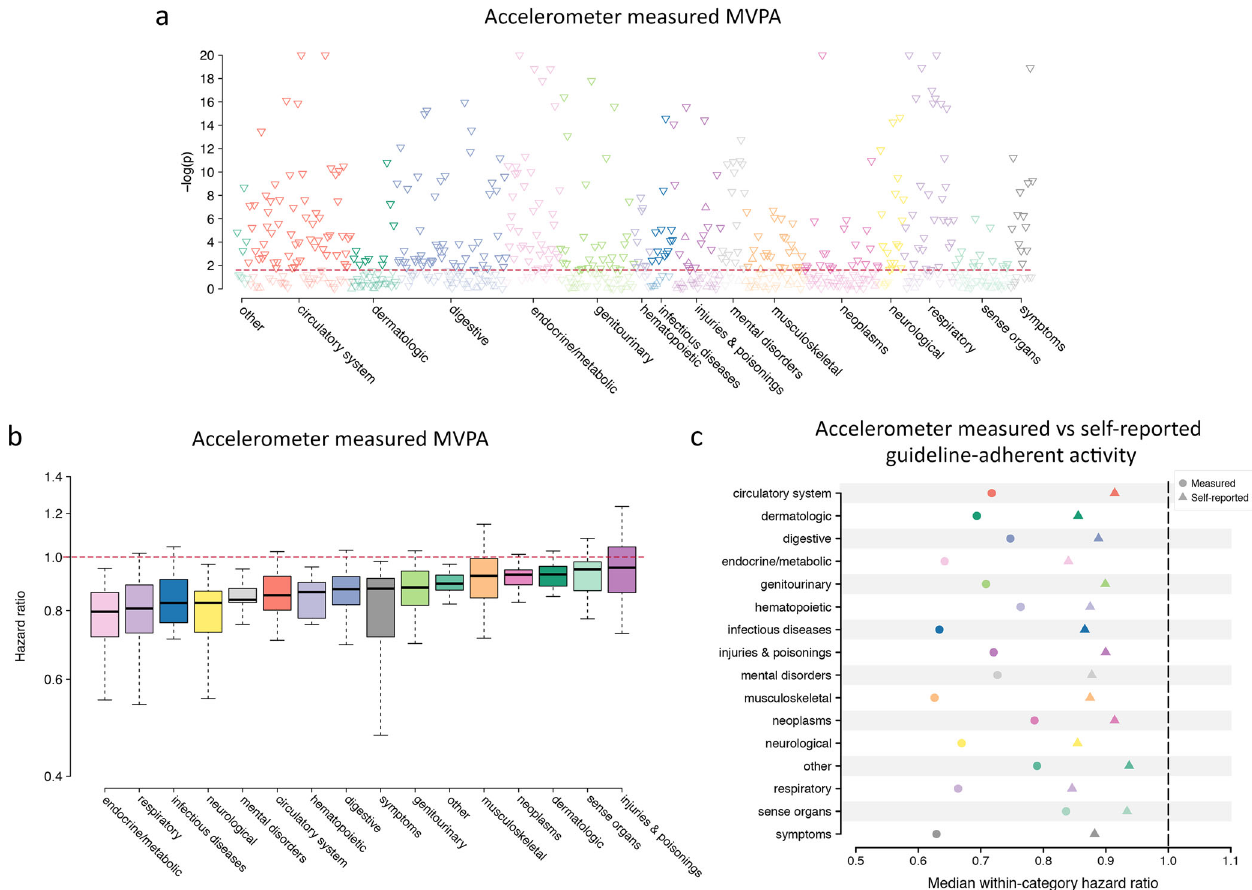
Fig. 2 Accelerometer-measured physical activity and incident disease. a Plots the negative log10 p value for the association between accelerometer-measured moderate-to-vigorous physical activity (MVPA) and incident disease (grouped by category on the x -axis) in Cox proportional hazards models adjusted for age, sex, body mass index, Townsend Deprivation Index, smoking status, alcohol use, anti- hypertensive medication use, systolic blood pressure, and diastolic blood pressure, with darker shaded points meeting signi fi cance at a false discovery rate (FDR) of 1% (horizontal red line). Upward-facing triangles represent higher risk (hazard ratios >1), while downward-facing triangles represent lower risk (hazard ratio <1). P values smaller than 1 × 10 − 20 are displayed as 1 × 10 − 20 for graphical purposes. b Shows the distribution of hazard ratios per 150-min increase in MVPA per week observed across each disease category ( x -axis), with the center line depicting the within-category median hazard ratio, the bounds of the box representing quartile 1 to quartile 3, and the whiskers extending 1.5 interquartile ranges beyond the box. Categories are arranged by increasing median hazard ratio, from lowest (left) to highest (right). c Compares the median within-category hazard ratio observed with guideline-adherent activity (i.e., ≥ 150 min of MVPA per week 1,10,11 ) de fi ned using accelerometer-measured (circles) versus self-reported (triangles) MVPA. Included in the comparison are 323 diseases for which there was a nominally signi fi cant association ( p < 0.05) with both exposure de fi nitions and an effect size suggesting a lower risk of